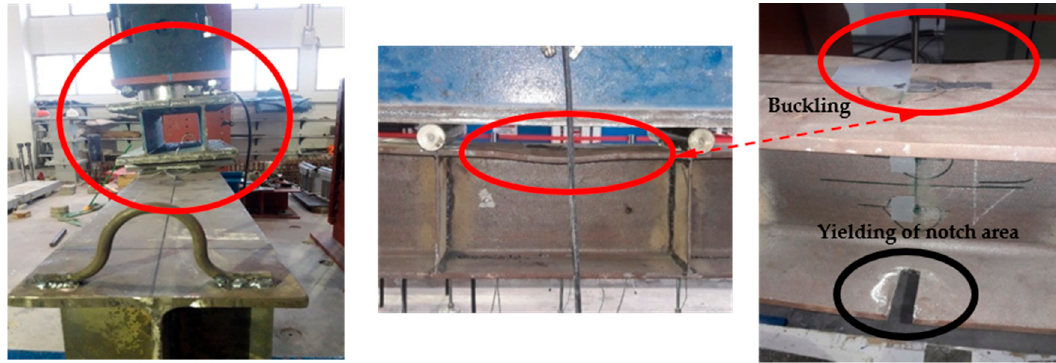
Figure 4. Failure mode of specimens.